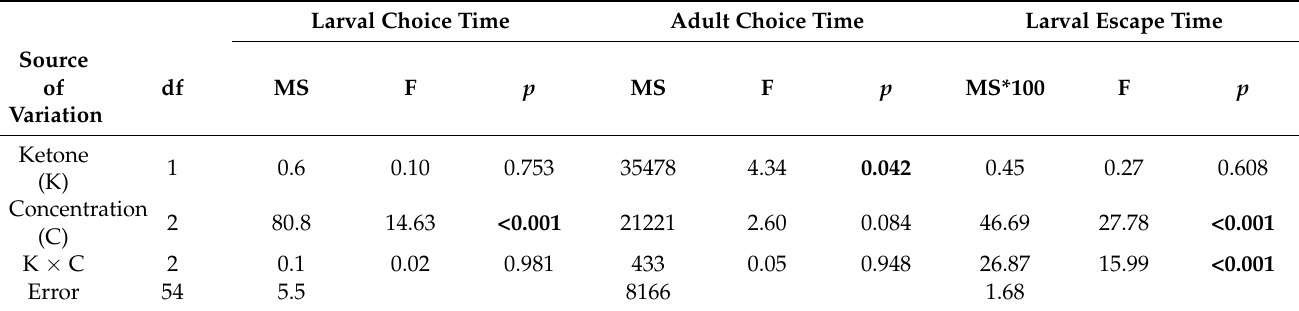
Table 4. Mean squares (MS), F and p values obtained from two-way ANOVA testing of the significance of the main (K—camphor or the thujone-camphor mixture, C—concentration) and interaction effects on the behavioural responses in the olfactometer (choice time) and the responses after the contact with the treated disc (escape time). Significant effects are marked in bold.